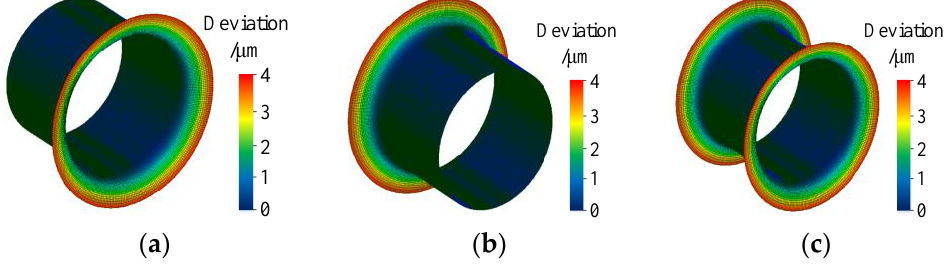
Figure 4. Full load spring force.